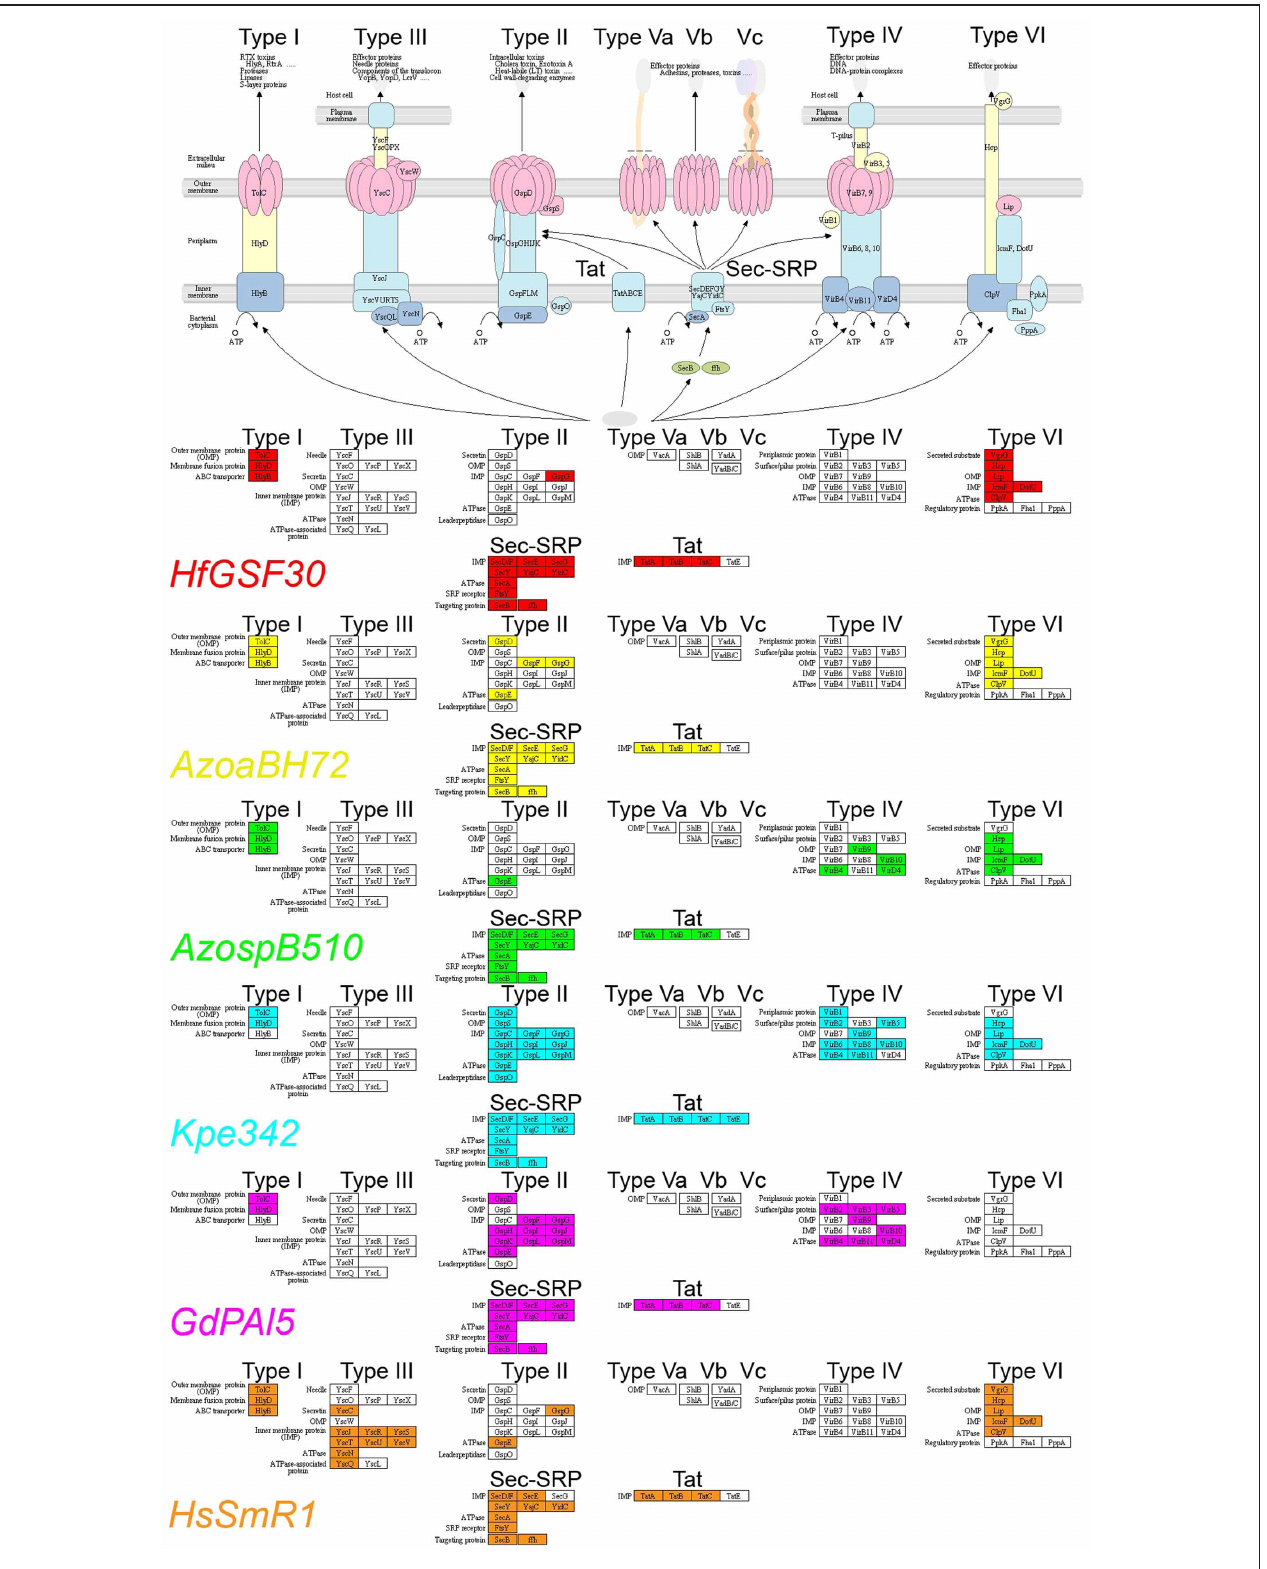
FIGURE 2 | Presence of secretion systems in HfGSF30 and comparison with other endophytes. HfGSF30 genome (red), AzoaBH72 (yellow), AzospB510 (green), Kp342 (blue), GdPAI5 (pink), and HsSmR1 (orange). Missing genes are shown in white.